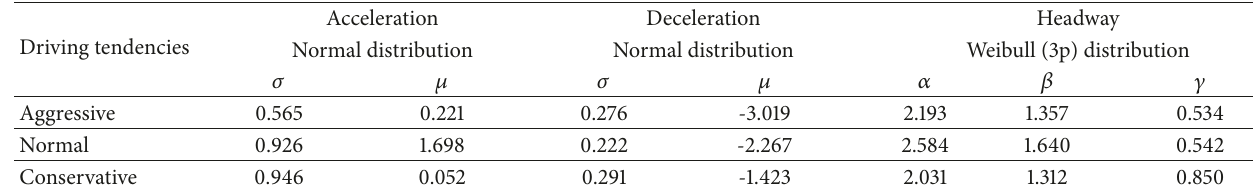
Table 2: The calibration of the